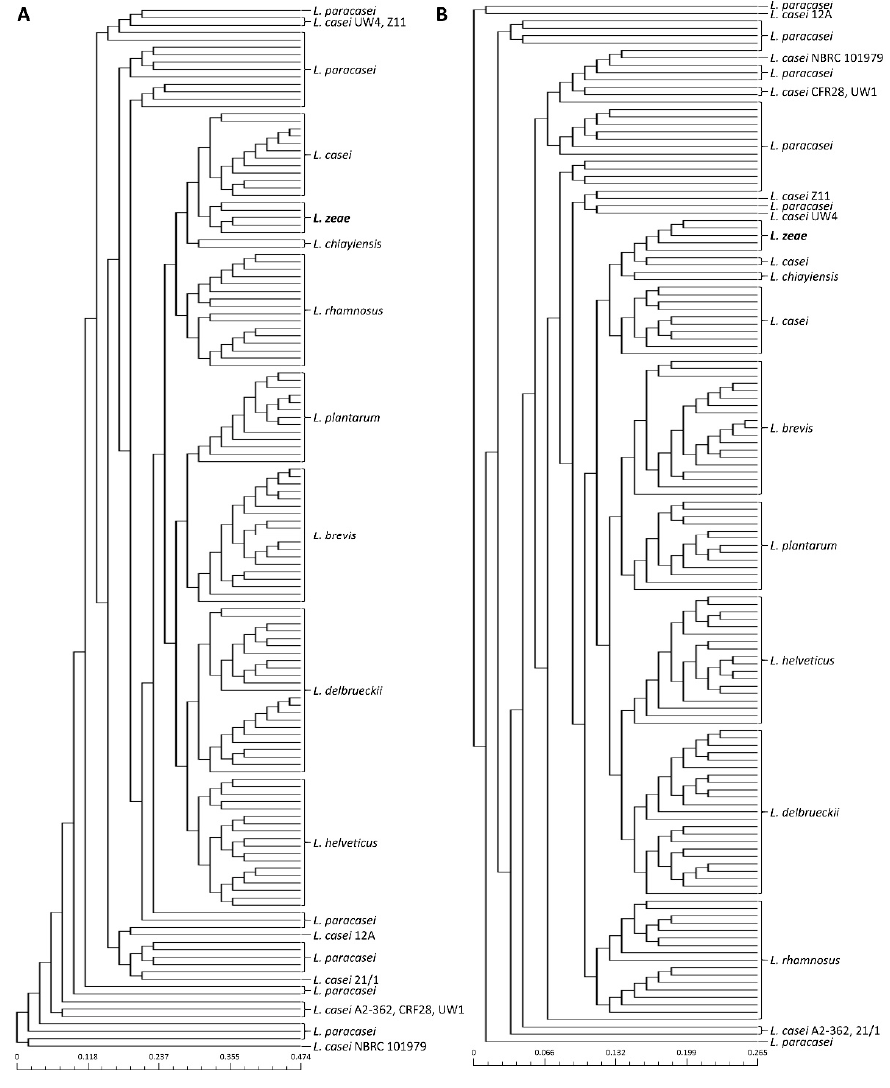
Figure 2. Phylogeny analysis based on ( A ) core-genome and ( B ) pan-genome matrix of 141 genome sequences.